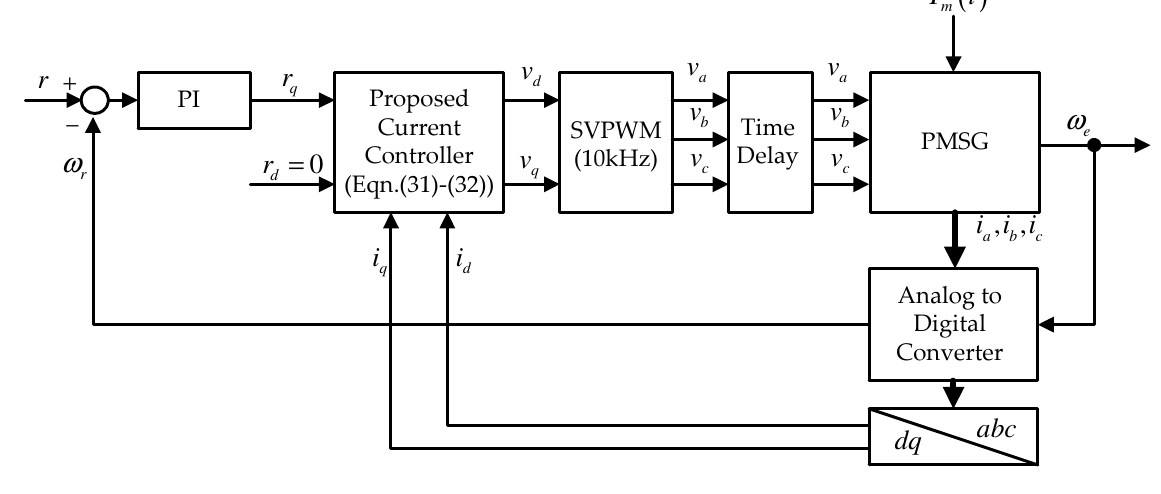
Figure 2. Simulated closed-loop